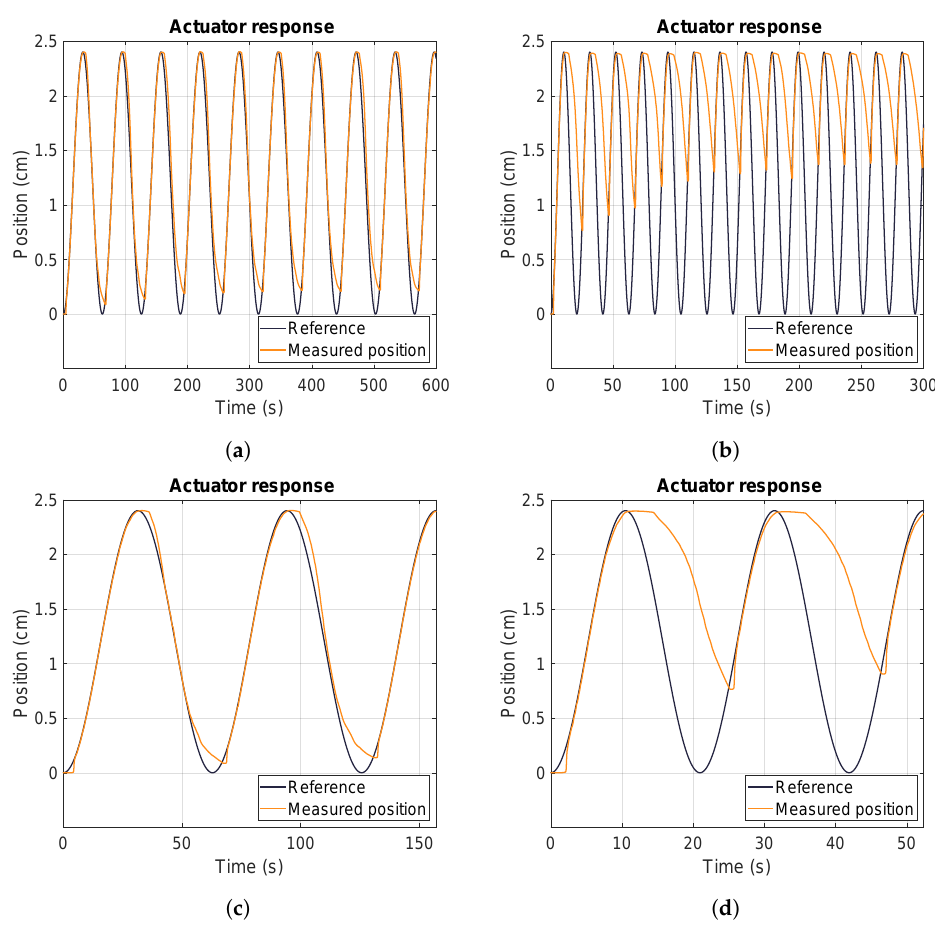
Figure 9. Comparison of the actuator’s responses at different working frequencies. ( a ) Overall response at a frequency of 0.1 rad/s and a load of 2.00 kg. ( b ) Overall response at a frequency of 0.3 rad/s and a load of 2.00 kg. ( c ) Details at a frequency of 0.1 rad/s and a load of 2.00 kg. ( d ) Details at a frequency of 0.3 rad/s and a load of 2.00